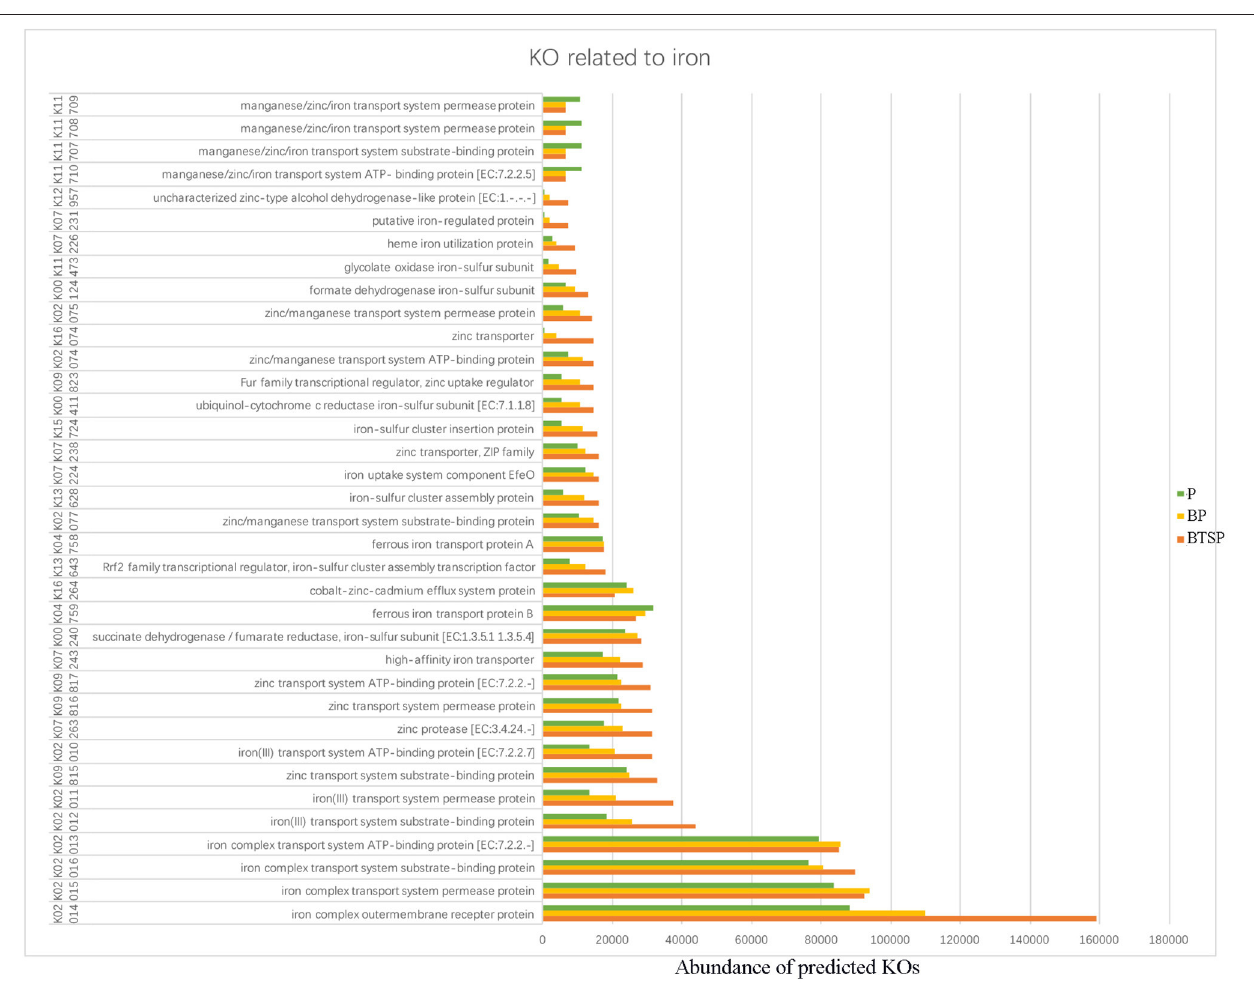
FIGURE 6 | The KEGG Orthology (KO) groups related to iron in plaque